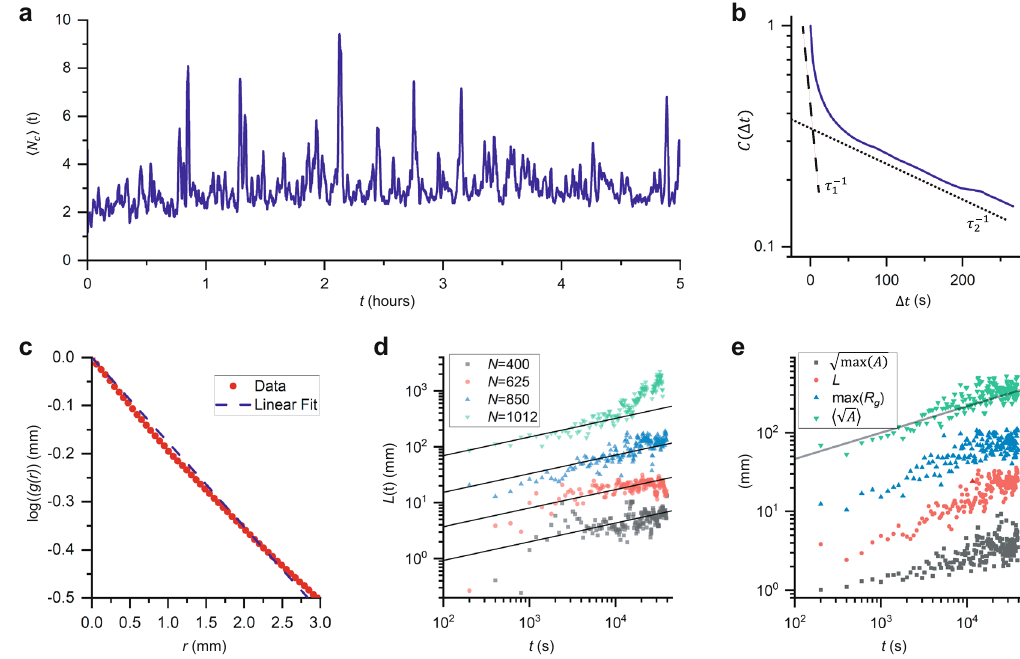
Fig. 7 | Cluster dynamics. a Average size of the clusters measured in the experi- ment with N =40 ants. The cluster sizes continually fl uctuate. b Autocorrelation function for an experiment with N =625 ants (solid navy line). We measure two timescales from this function, τ 1 (dashed line) and τ 2 (dotted line). c The spatial autocorrelation function of pixels associated to the stationary phase as a function of time for an experiment with N =625. The dashed line is the best linear fi t of